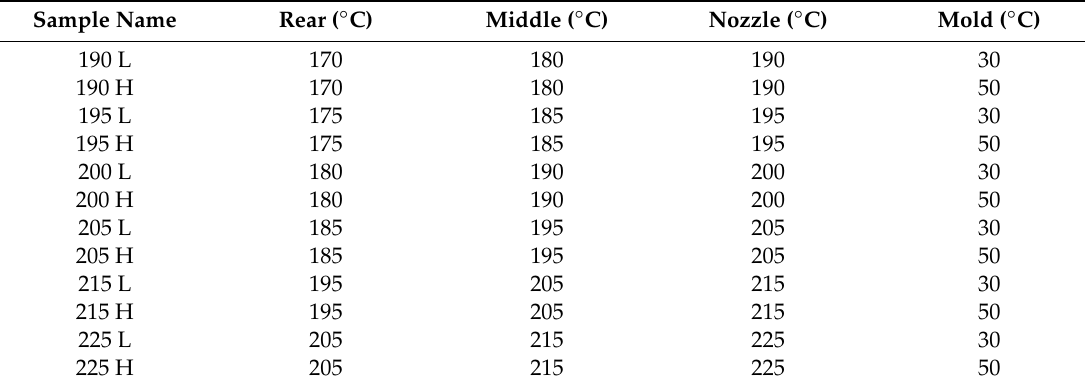
Table 1. Di ff erent processing conditions for each